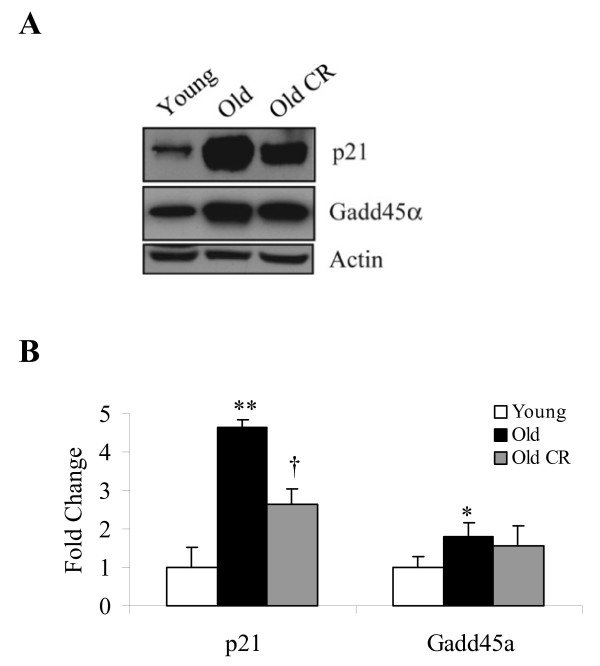
Protein levels for p21 and GADD45a in mouse skeletal muscle. (A) Representative western blot for p21 and GADD45a staining in young, old and old CR skeletal muscle. (B) Expression ratio information on protein levels (n = 3 and n = 4 for p21 and Gadd45a respectively for each age and diet). One-tailed Student's t-test; *P < 0.05, **P < 0.005 (young verses old), †P < 0.005 (old versus old CR).